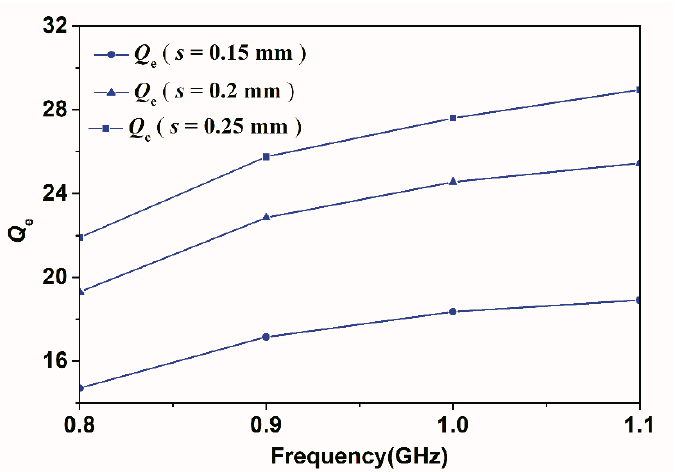
Figure 6. Extracted Q e versus f C with different s .